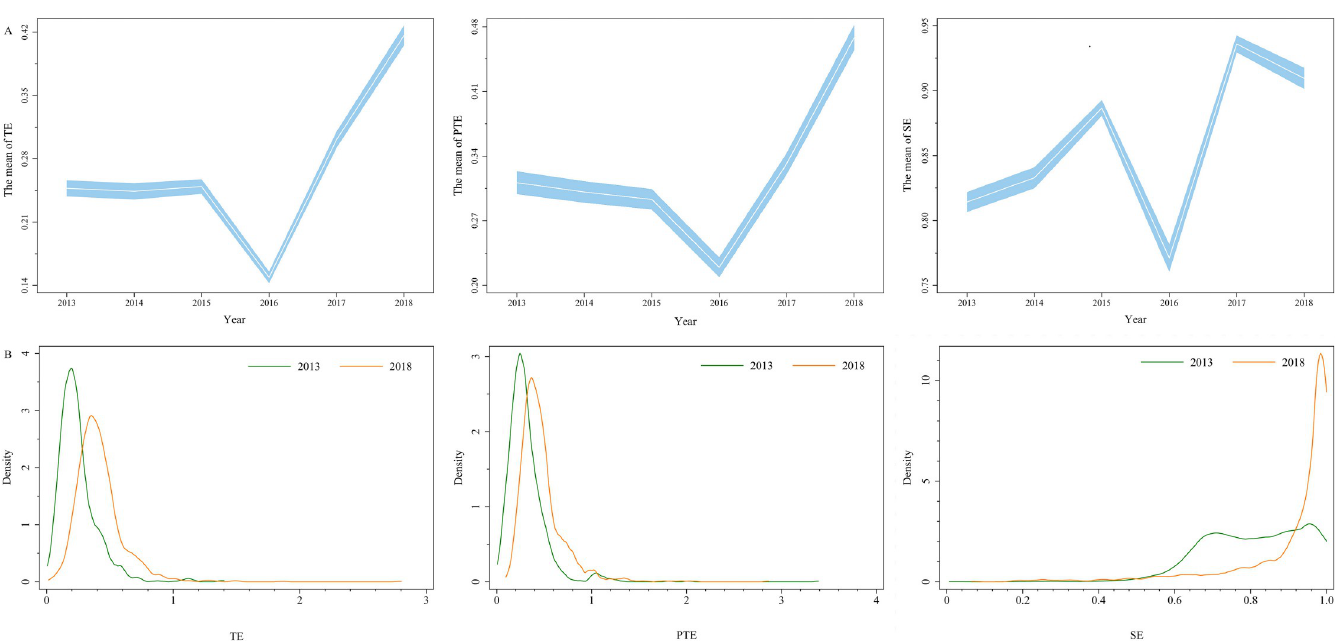
Fig 2. The mean value and kernel density of rural TCM hospital efficiency from 2013 to 2018. A: The mean value of TE, PTE and SE; B: Kernel density curve of TE, PTE and SE.